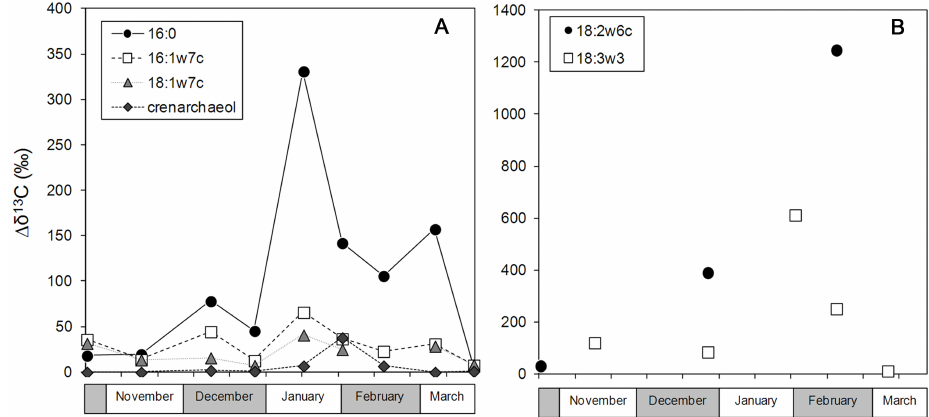
Fig. 5. 1δ 13 C values for individual PLFAs and crenarchaeol inhibited by nitrapyrin (i.e. ( 1δ 13 C without inhibitor) – ( 1δ 13 C with ni- trapyrin)). Note difference in scales for (A) and (B)